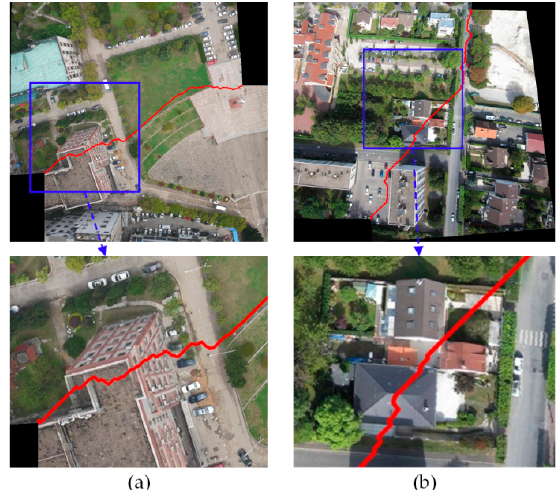
Figure 3. The stitching results using the Duplaquet algorithm for two datasets. ( a ) The experimental result with UAV images shot in Wuhan; ( b ) The experimental result with UAV images shot in Paris.